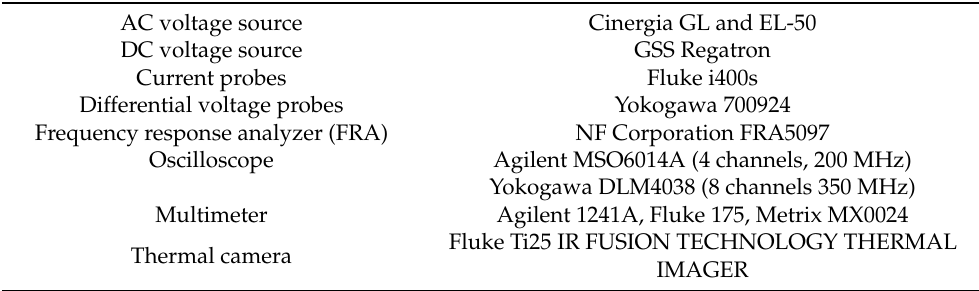
Figure 6. Experimental set-up. Table 5. Instruments and laboratory